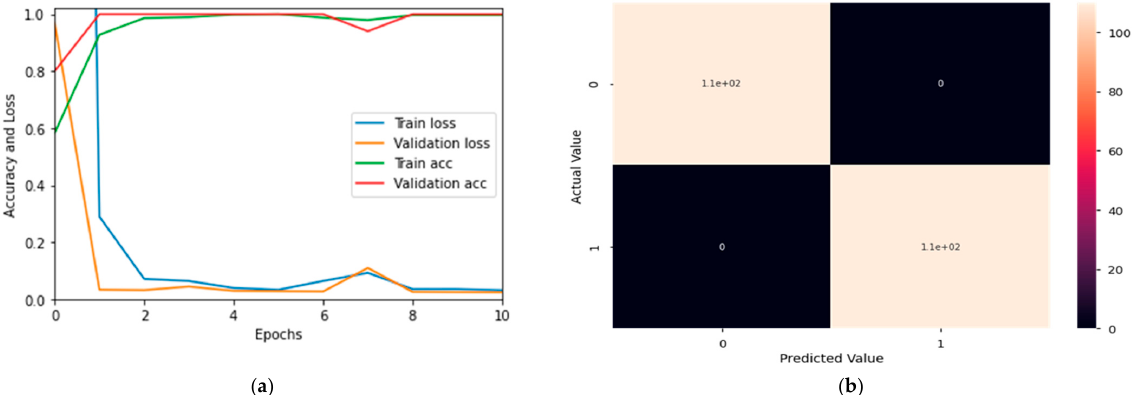
Figure 11. ( a ) A visual representation of accuracy and loss on training and validation on DRIVE and ( b ) Confusion matrix of implemented CAD-HR on DRIVE.